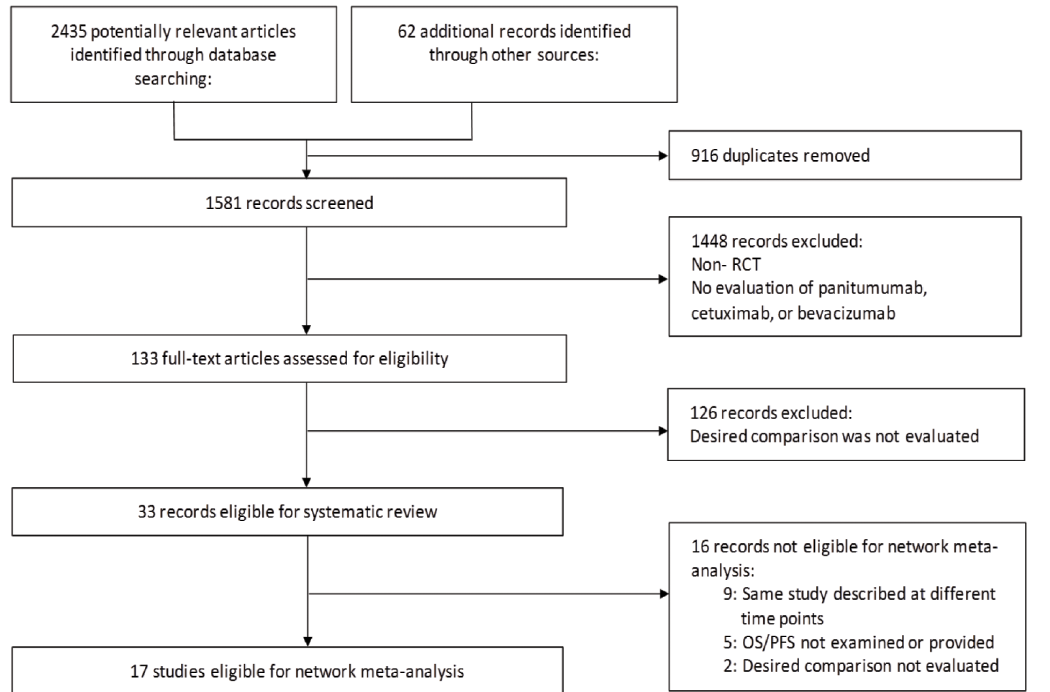
Fig 1. PRISMA flow diagram of included and excluded trials identified from the literature search.